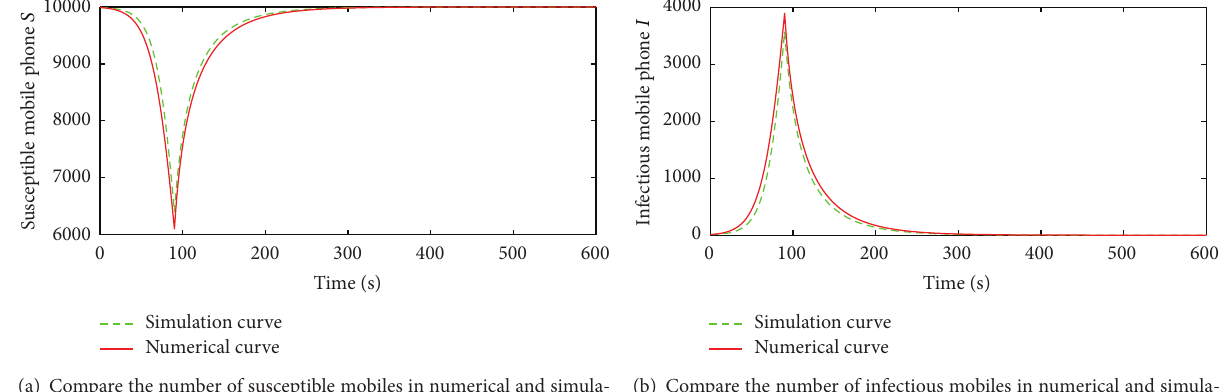
Figure 5: Comparison of numerical and simulation result.